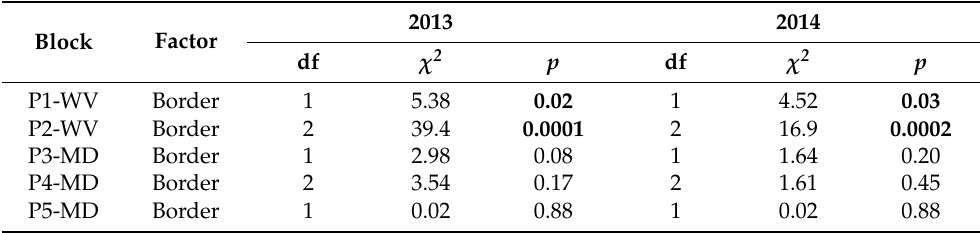
Table 5. Summary of statistical results for incidence of external fruit injury from H. halys on the perimeter of 5 peach blocks in 2013 and 2014 in the Mid-Atlantic USA. Significant p values are highlighted in bold